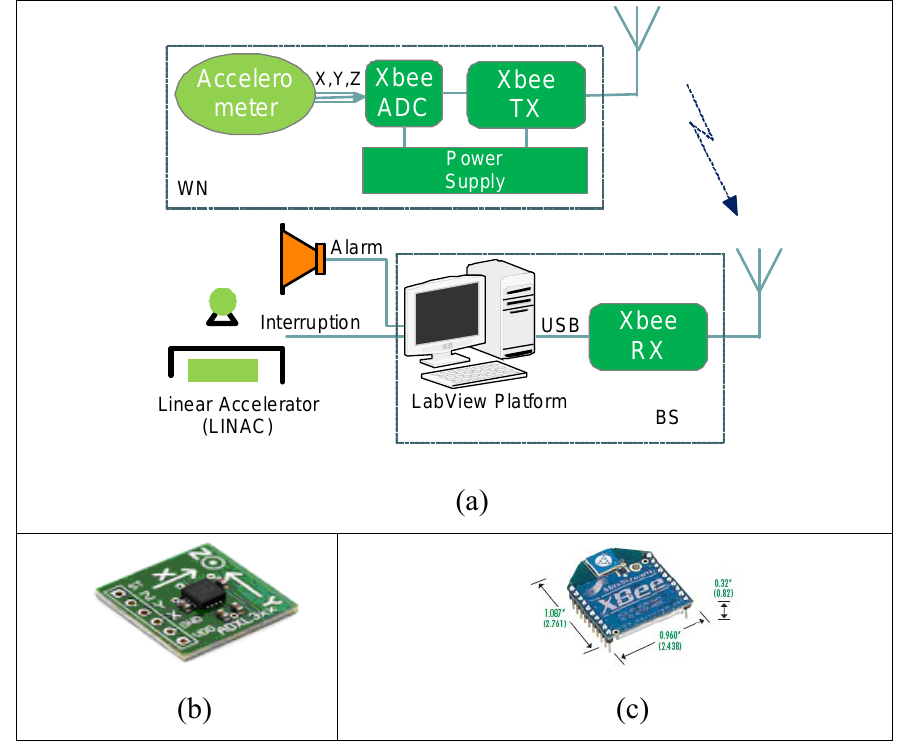
Figure 3. (a) Basic block diagram of APOMS; (b) ADXL330 accelerometer mounted on the breakout board; (c) Xbee